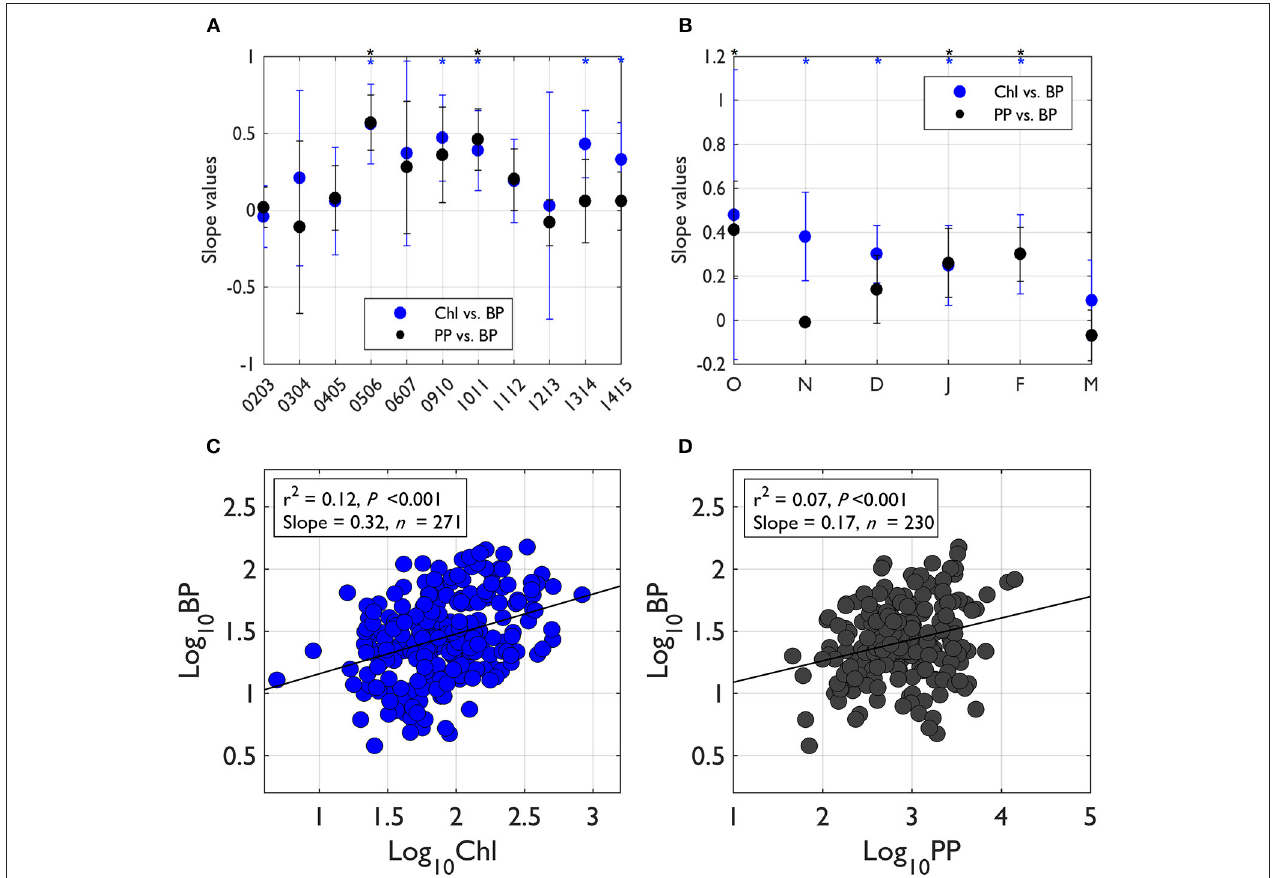
FIGURE 4 | The degree of bacterial-phytoplankton coupling based on the slope values from log-log regressions of phytoplankton properties (PP, Chl)-BP. The degree of BP coupling with phytoplankton activity (PP) and biomass accumulation (Chl) was assessed using the slope values from log-log regressions of PP (or Chl)-BP (asterisk on top of plot indicates significant regressions at P < 0.05). For each individual year’s slope values (A) , the slope values for each year were calculated by pooling all monthly data in that particular year. For seasonal slope values (B) , the slope values for each month were calculated by pooling all individual years’ data in that month. When pooled for all seasons and years (C,D) , the regression slope value for Chl-BP was 0.32 ( r 2 = 0.12, P < 0.001, n = 271) and the regression slope value for PP-BP was 0.17 ( r 2 = 0.07, P < 0.001, n = 230). Error bars indicate standard deviation of the slope value at 95%